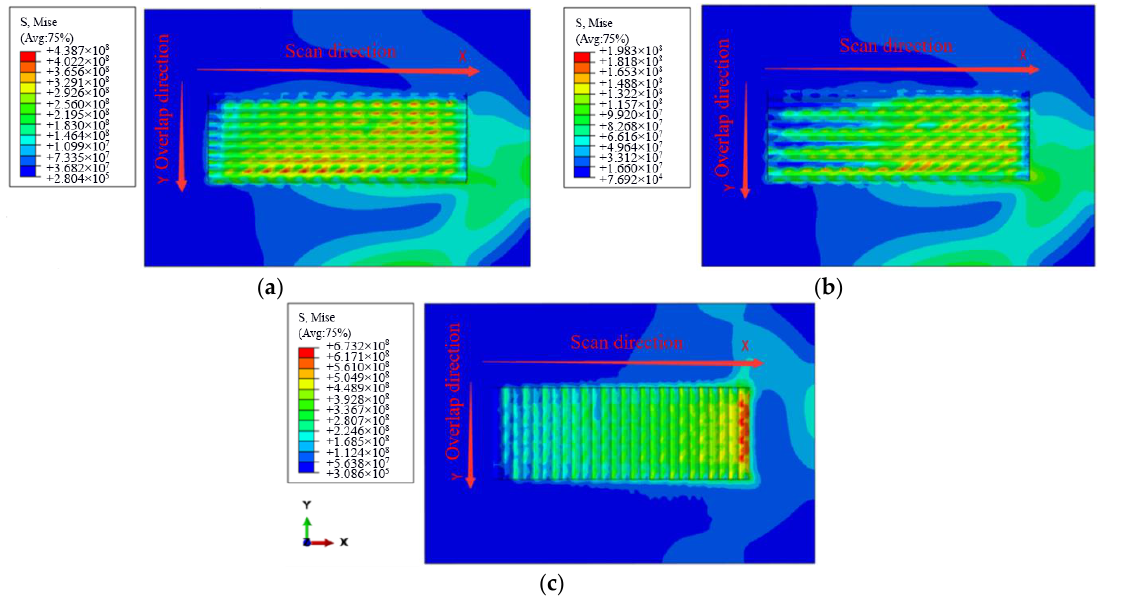
Figure 7. Residual stress nephogram distribution: ( a ) Long-edge successive scanning; ( b ) Long-edge reciprocating scanning; ( c ) Short-edge reciprocating scanning.